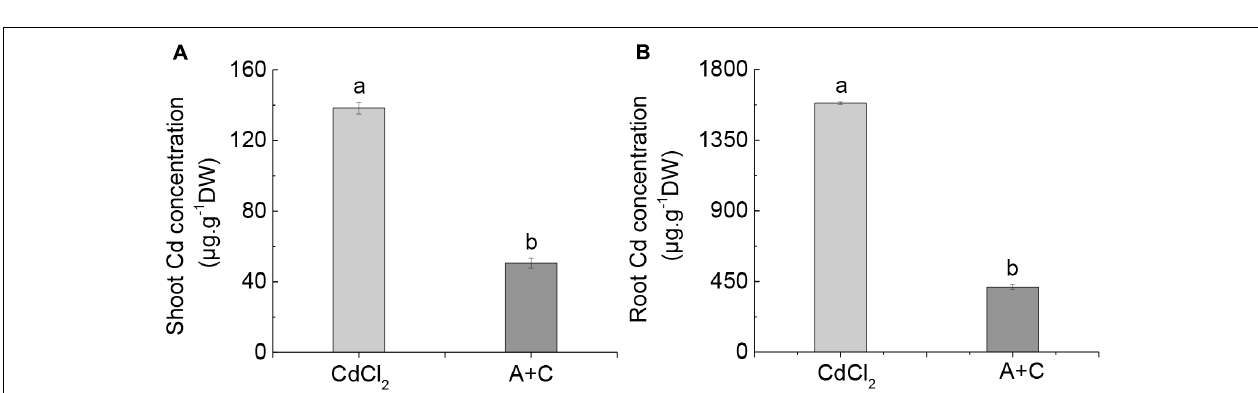
FIGURE 7 | Effect of exogenous ABA on Cd uptake. Cd concentration in the shoot (A) and root (B) under Cd and (A+C) treatment. Data represent means ± SE ( n = 4). Bars with the same letter indicate no significant difference at P < 0.05 level by the method of LSD.